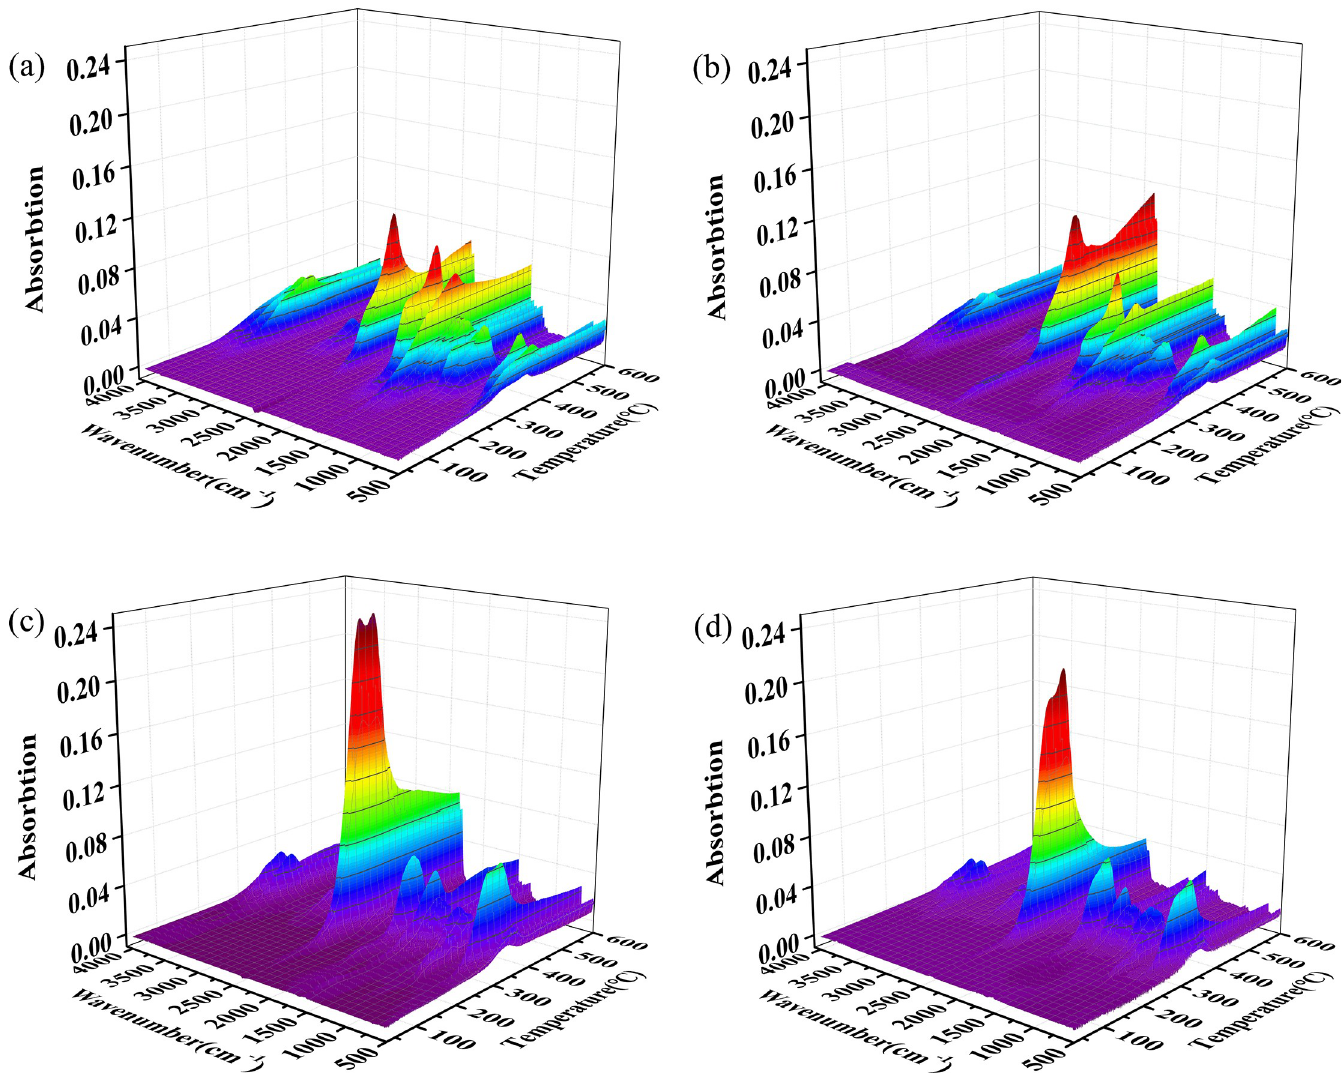
Fig 7. 3D spectrogram of TG-FTIR of Untreated(a), HT(b), IMPG(c) and IMPG-HT(d) samples at the heating rate of 20˚C min -1 .